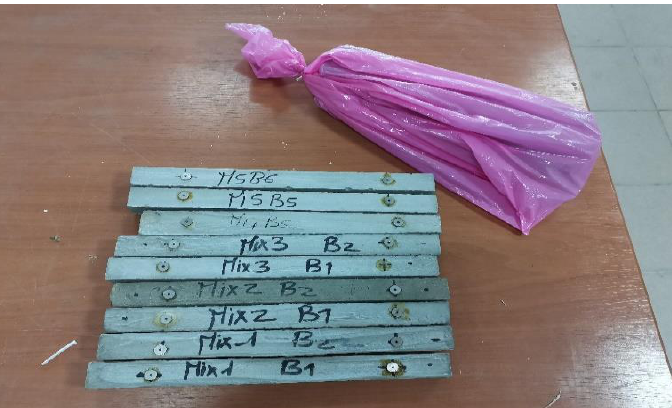
Figure 4. Autogenous and drying shrinkage specimens.